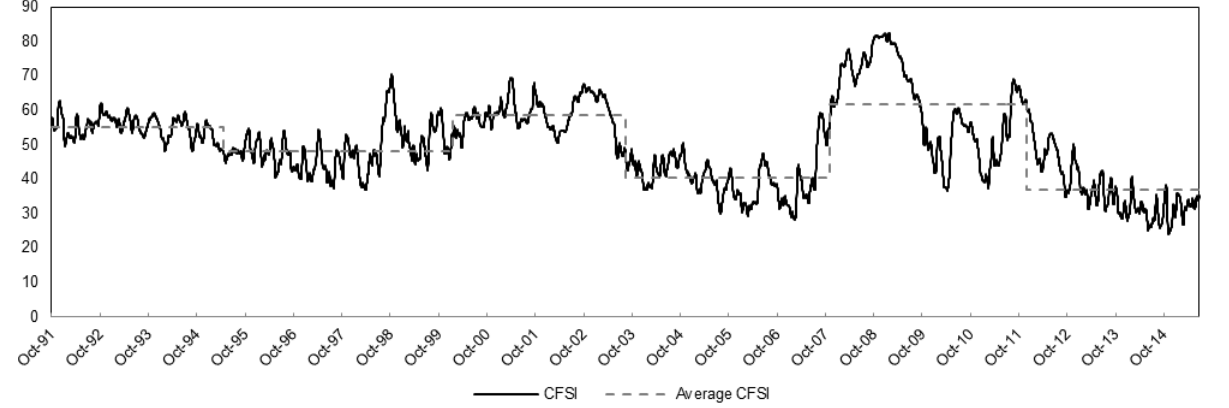
Figure 7. Structural breaks in the